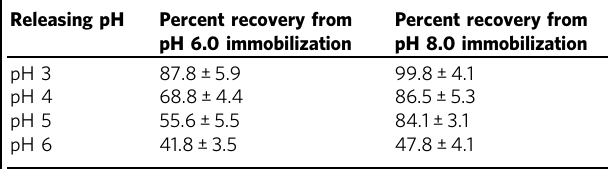
The release rate and total amount of protein recovered are pH dependent with the highest recovery at pH 3 after 60min. Error bars indicate standard deviation from triplicate measurements Errors indicate standard deviation from triplicate